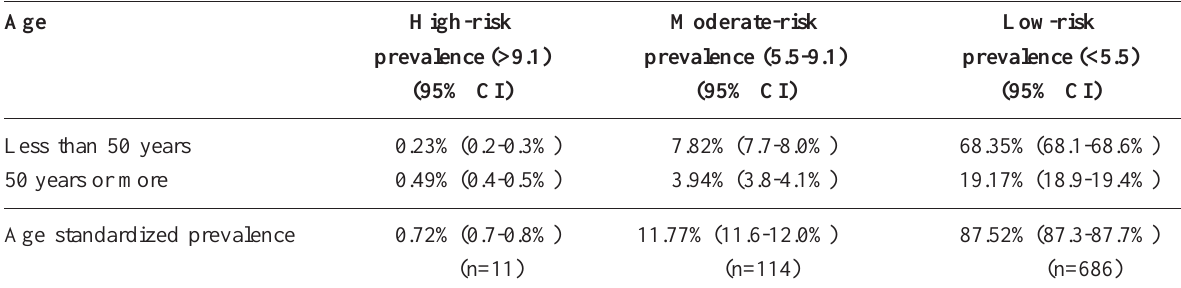
Table 4. Prevalence of ‘at risk’ population by age categories and age-standardized prevalence